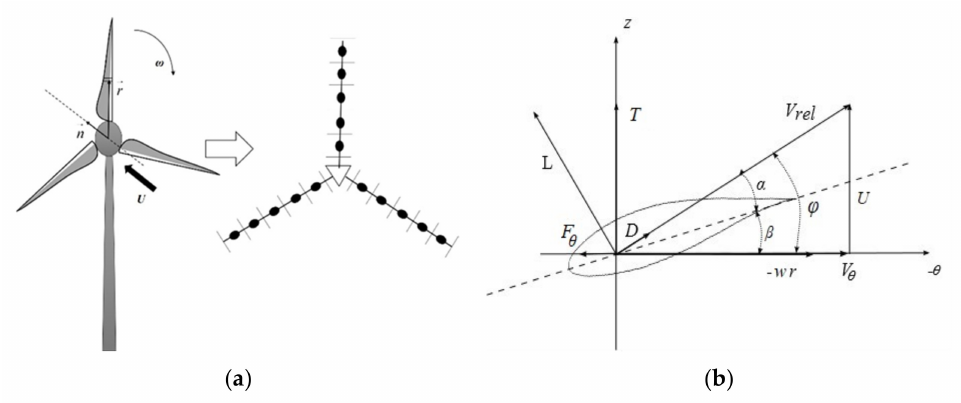
Figure 1. Actuator line model. ( a ) Rotation of the wind rotor; ( b ) Triangle of the blade